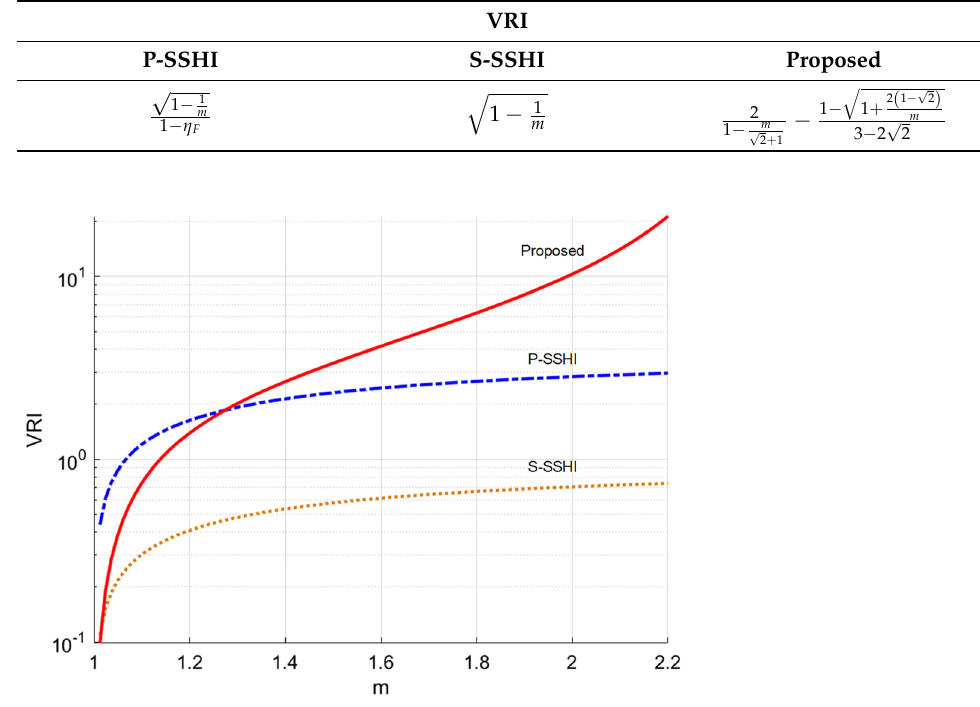
Figure 10. VRI versus m.